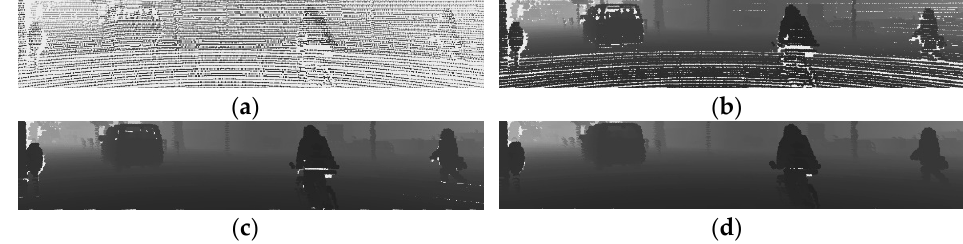
Figure 6. Generated grayscale depth image with different size of point cloud: ( a ) size = 1; ( b ) size = 3; ( c ) size = 5; ( d ) size = 7.